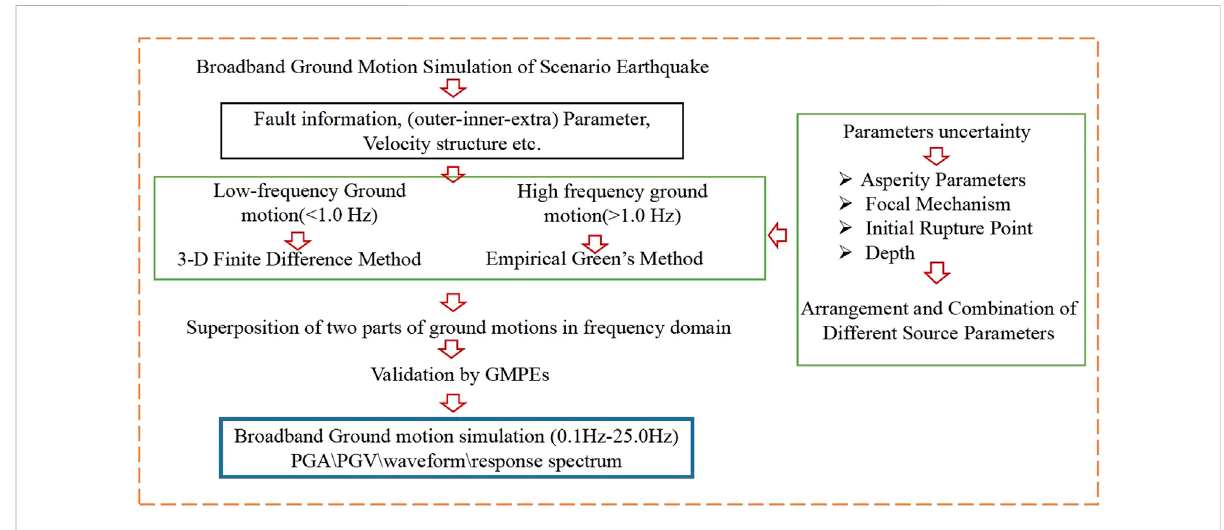
FIGURE 2 Flowchart of scenario earthquake broadband ground motion simulation in Pingwu Area.